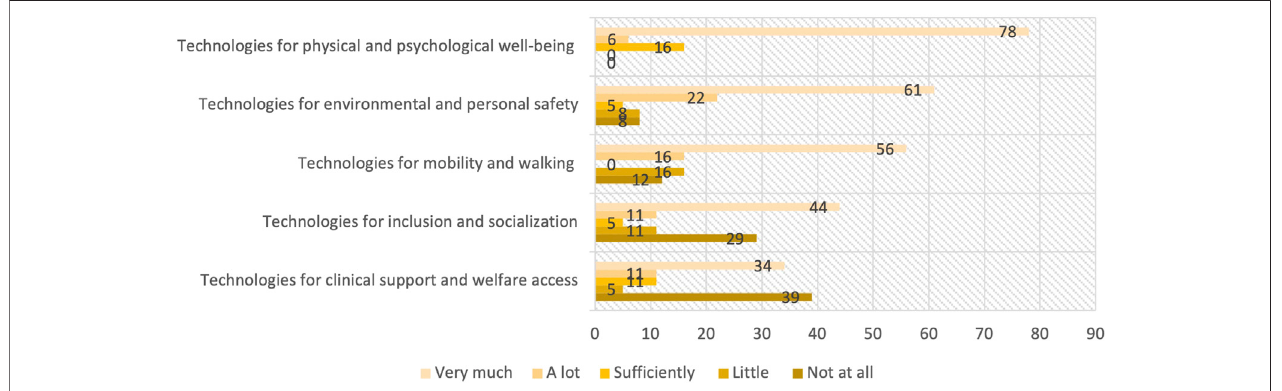
FIGURE 4 | Technology relevance and sectors.